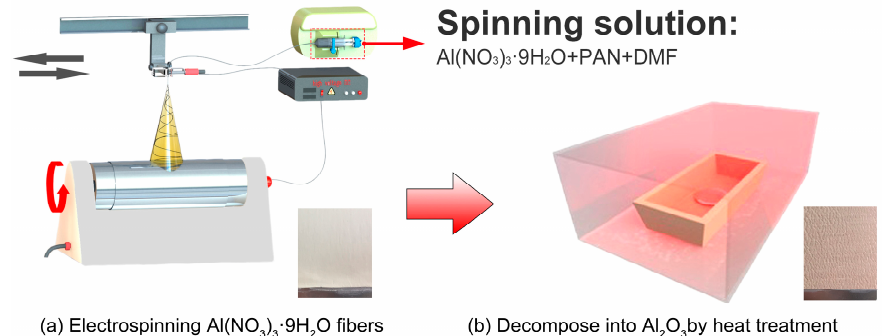
Figure 1. Schematic illustration of the preparation of Al 2 O 3 coatings. Electrospun Al(NO 3 ) 3 · 9H 2 O, polyacrylonitrile (PAN) and N,N-dimethylformamide (DMF) mixed solution on zinc substrate ( a ). Heat treated the electrospun films in mu ffl e furnace in an atmospheric environment to obtain Al 2 O 3 coatings ( b